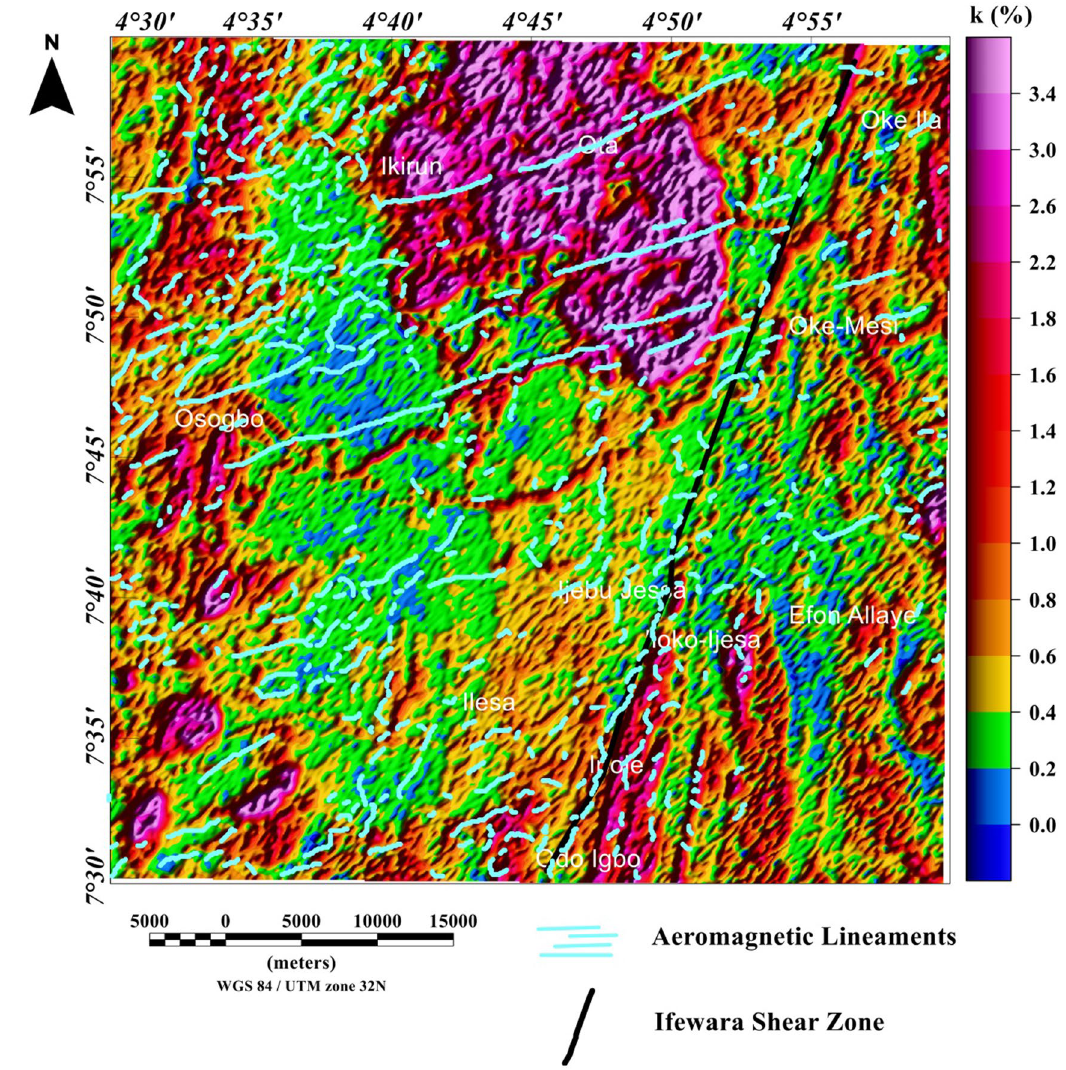
Figure 12. Map of potassium (%) data of the Ife-Ilesha schist belt with superimposed Ifewara shear zone extracted from the total gradient amplitude map presented in color-shaded relief, illuminated from the east- southeast direction. The east-southeast illumination (azimuth: 112.5 degrees and light angle: 45 degrees) enhances east-northeast lineaments. The figure was produced using Oasis Montaj Software version 8.3.3 (Website: https:// www. seequ ent.